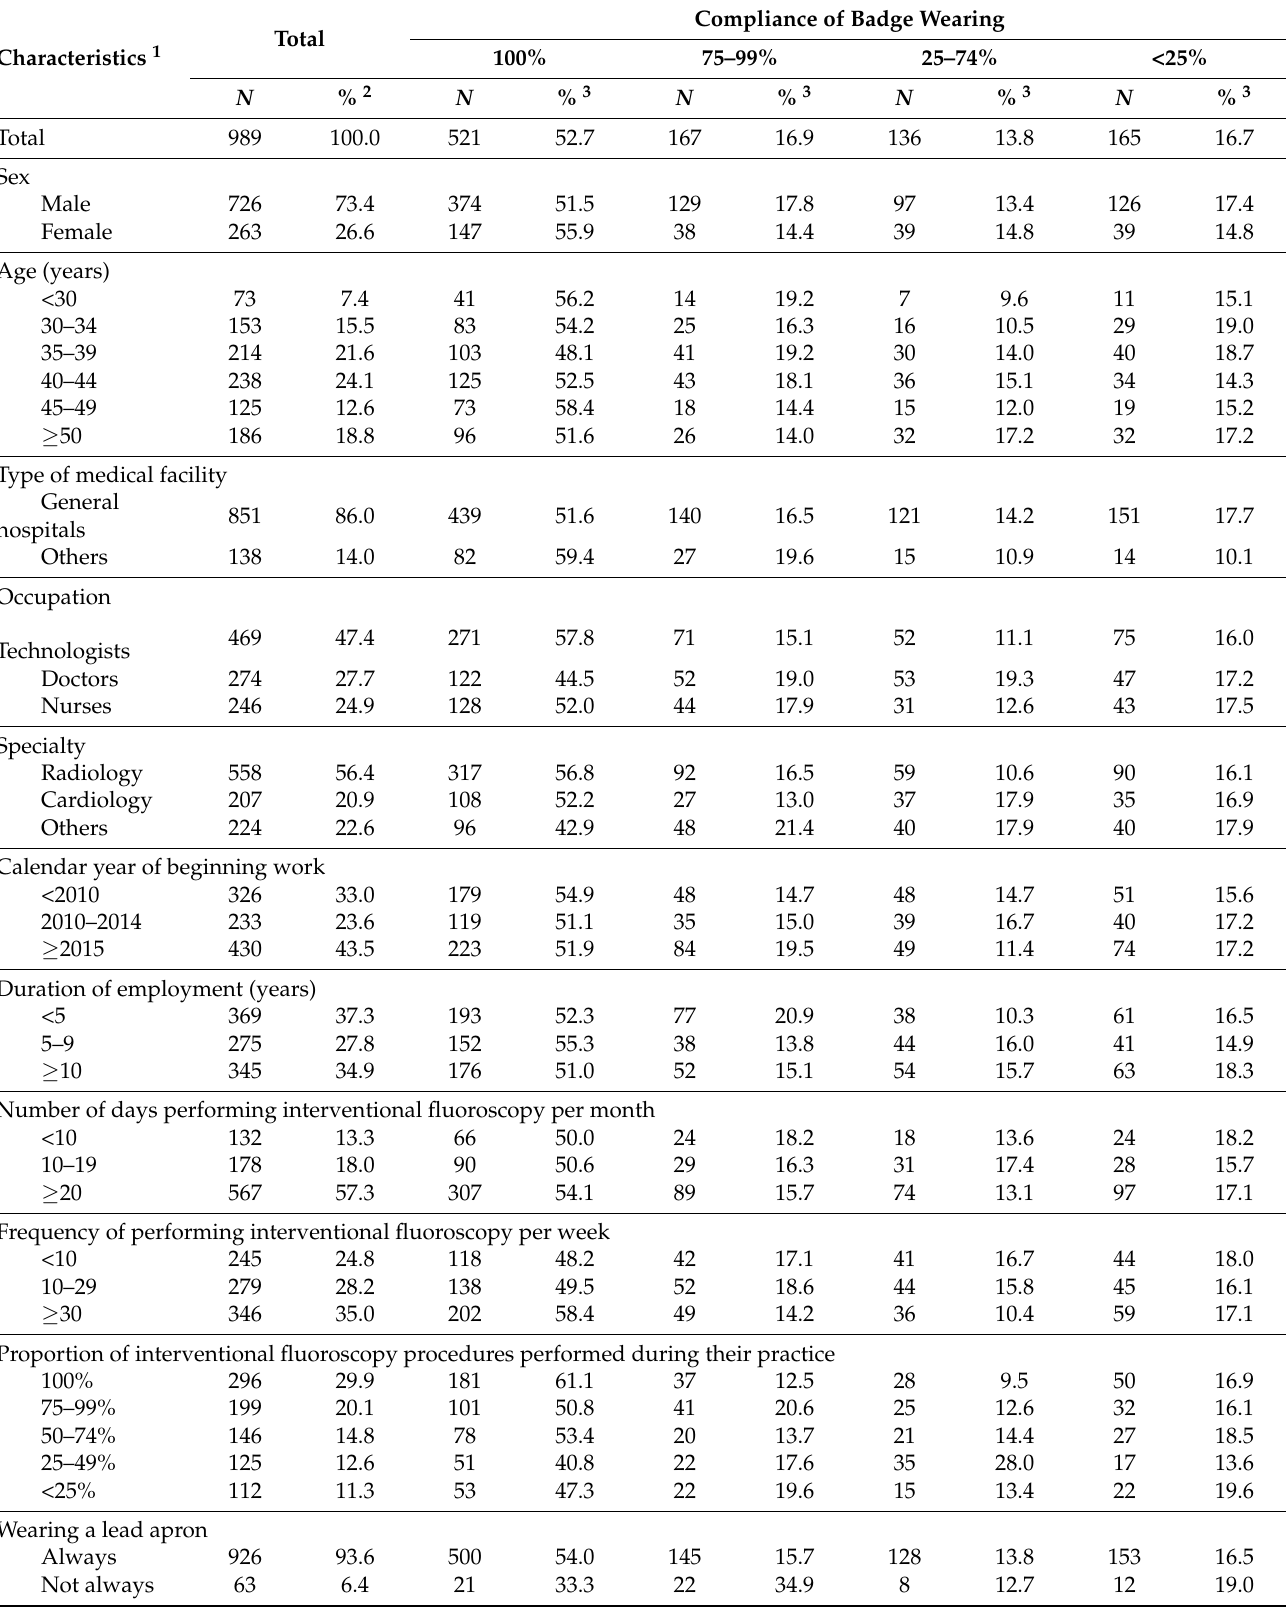
Table 1. Demographic and occupational characteristics of the study participants by level of dosimeter wearing